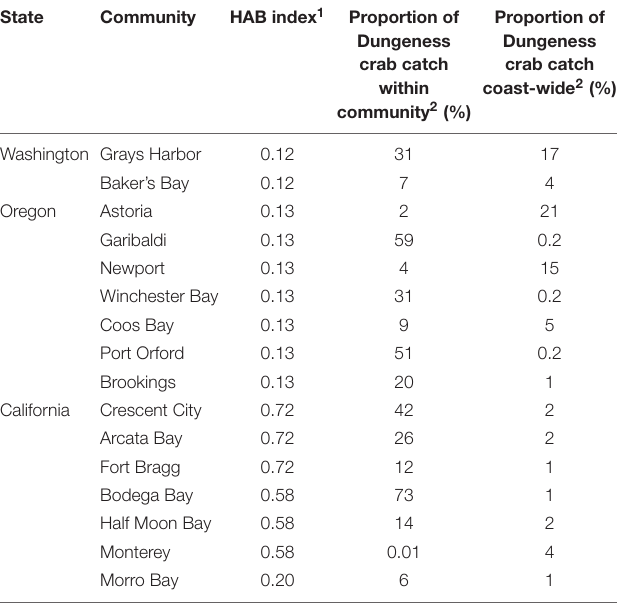
TABLE 1 | Fishing communities targeted by the